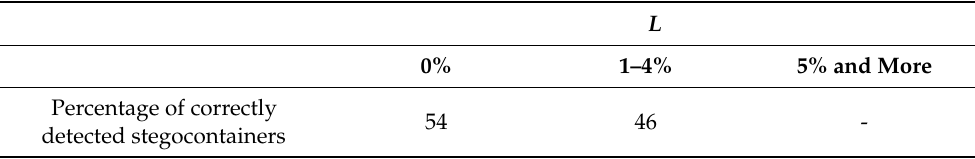
Table 1. RS analysis on a set of 225 × 225 empty containers.